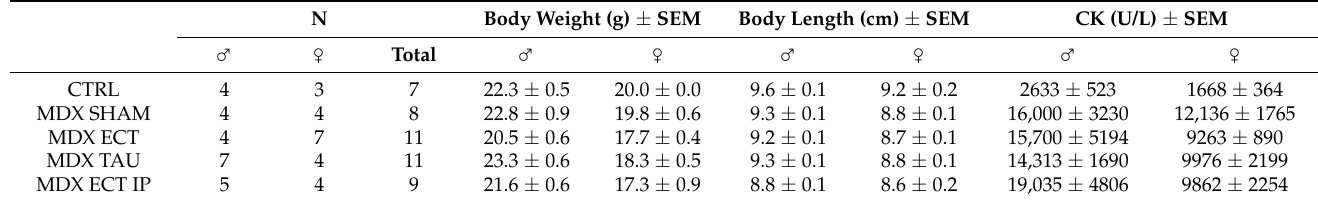
Table 1. Mouse phenotype data. Body weight, body length and serum CK values were determined. Mean values ± SEM are reported for both sexes in each group to allow better interpretation. N Body Weight (g) ± SEM Body Length (cm) ± SEM CK (U/L) ± N